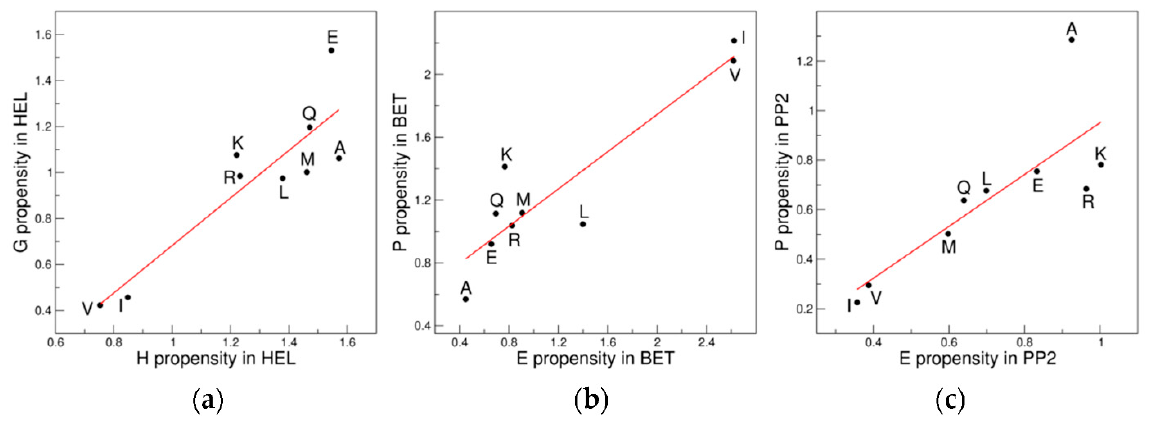
Figure 9. Significant correlations of the propensity scales for different secondary structure elements in the same ( φ , ψ ) clusters detected in the 9AA ensemble: ( a ) HEL_H versus HEL_G; ( b ) BET_E versus BET_P; and ( c ) PP2_E versus PP2_P.